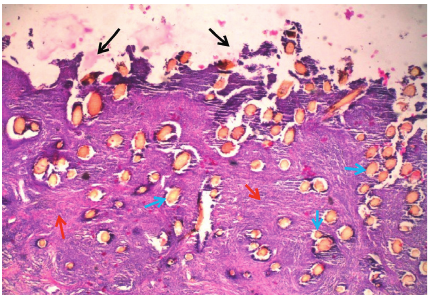
Figure 11: Numerous Opuntia stricta thorns deep in the muscles of the goat lip and the associated multifocal granulomas (blue arrows). The epidermal layer is necrotized and eroded (ulcerated) (black arrows), and skeletal muscles have been replaced by granulomatous tissue reaction (red arrows) in a goat with severe chronic cheilitis (H&E